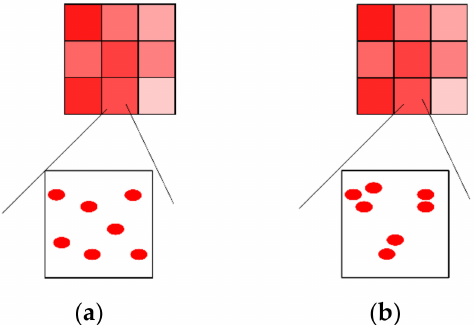
Figure 3. The refractive index distribution resolved by computational fluid dynamics (CFD) mesh and the actual distribution of air molecules: ( a ) Molecules are uniformly distributed in a grid; ( b ) molecules are nonuniformly distributed in a